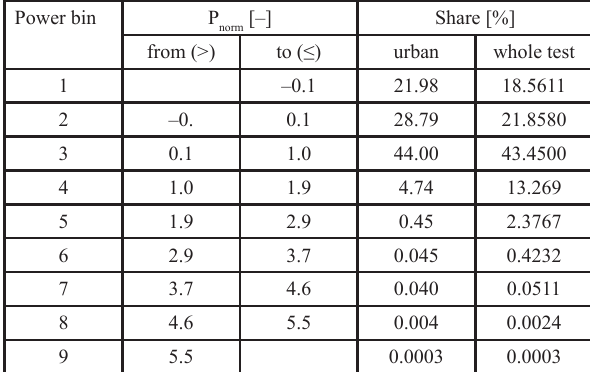
Table 3. Normalized shares of power for vehicle in an urban environment and the entire RDE